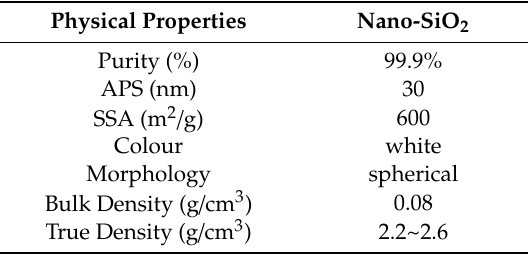
Table 2. Basic technical index of nano additive.